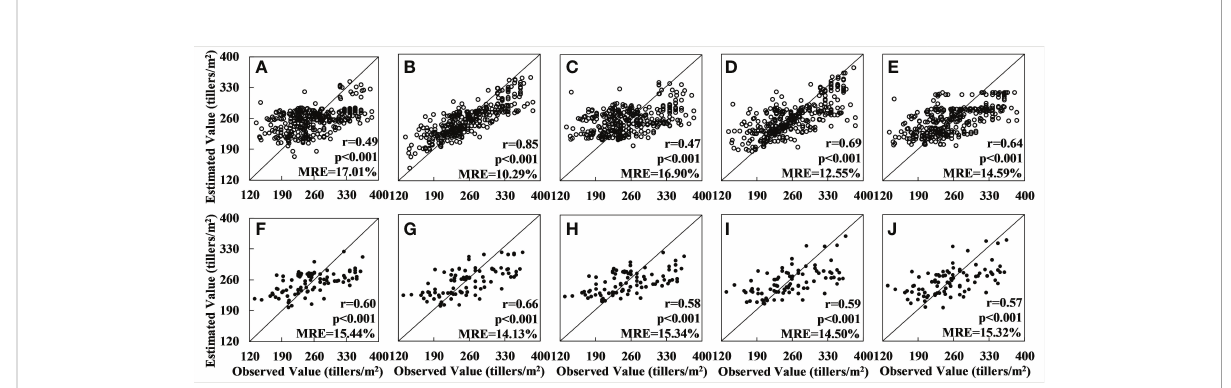
FIGURE 6 Accuracy of tiller density estimates based on Sentinel-2 data for the whole Xiaotangshan study area: (A – E) are the regression results for, respectively, the models OLS, RF, SVM, GBRT, and XGBoost for the training set; (F – I) are the regression results for the same fi ve models for the validation set.